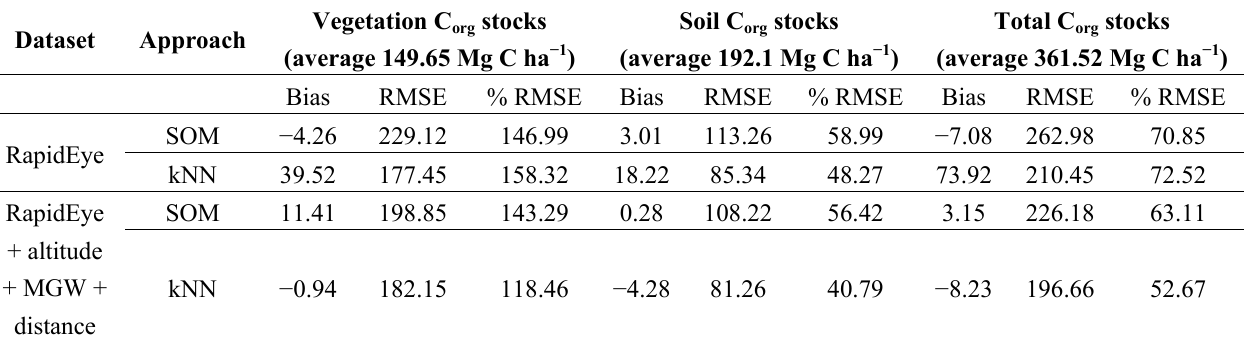
Table 3. Error estimates from SOM and kNN for vegetation, soil and total C the Danube Floodplain (SOM: start distance δ 100, and have five iterations (t weight w : ( i ), p